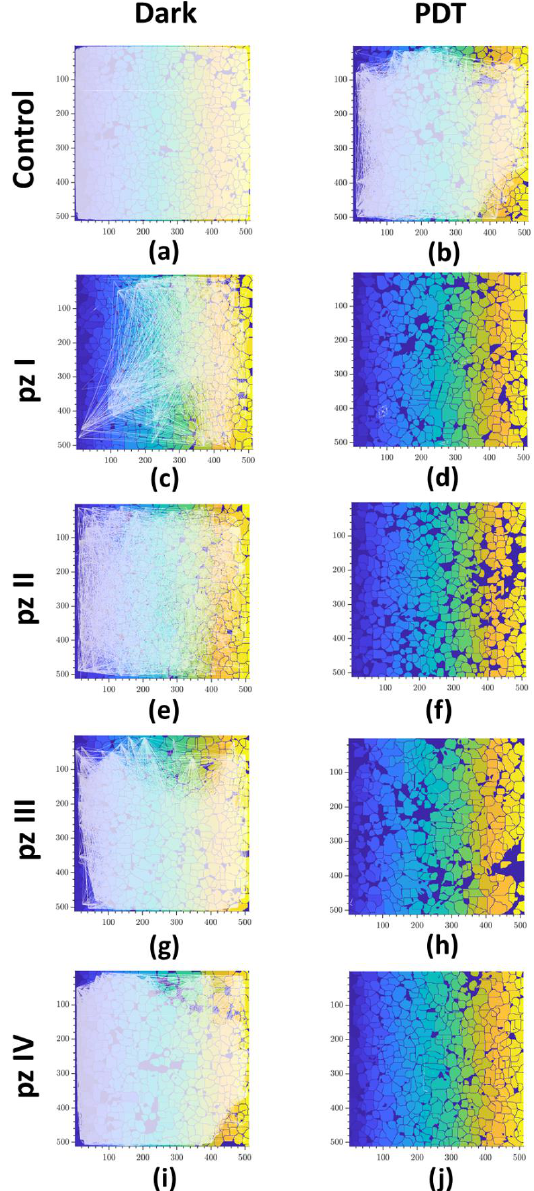
Figure 4. Representative correlation network graphs of primary hippocampal cultures the next day after PDT. Each white line schematically represents the connection between cells. The line is plotted on the graph if the correlation level of Ca 2+ oscillations is greater than the empirically calculated value 0.3: ( a ) control dark, ( b ) control PDT, ( c ) pz I control, ( d ) pz I PDT, ( e ) pz II control, ( f ) pz II PDT, ( g ) pz III control, ( h ) pz III PDT, ( i ) pz IV control, and ( j ) pz IV